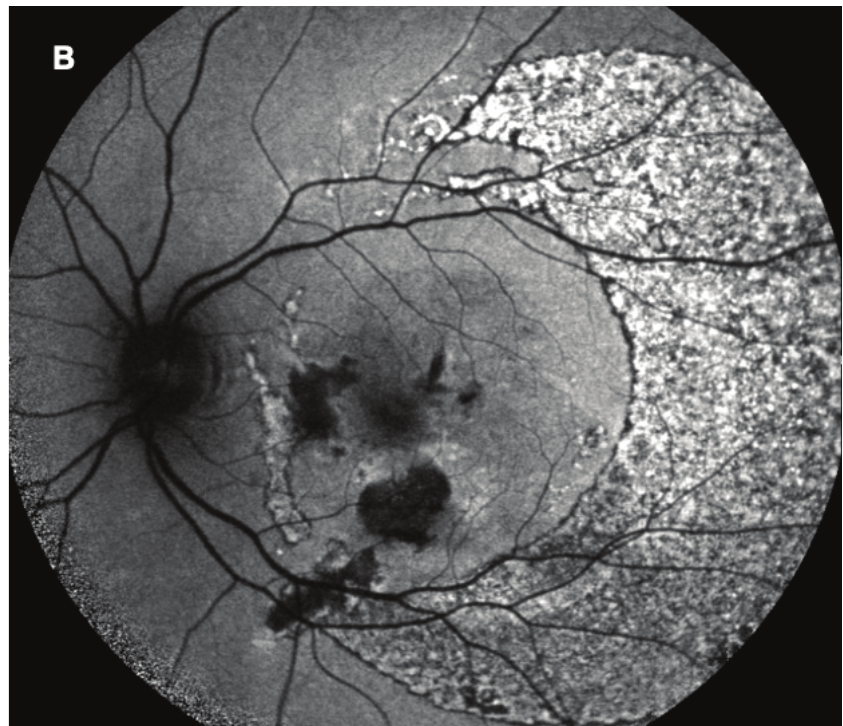
Figure 3. Fundus autofluorescence demonstrating the area of damaged retinal pigment epithelium over the macula that extends temporally at one month postoperatively. There is diffuse hyper-autofluorescence temporal to the macula with areas of hypo- autofluorescence, demonstrating likely retinal pigment epithelium atrophy with areas of hyperplasia.